Question: Author a descriptive caption for the visualization shown.
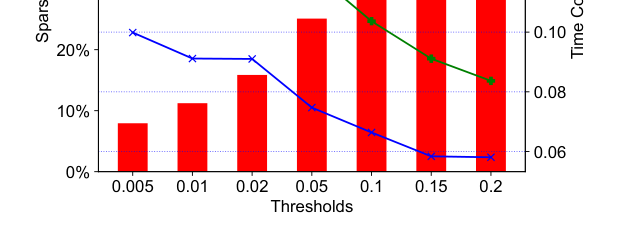
Answer: Variation of sparsity and the ability to keep sensitive information under different thresholds. Images are tested in the latent space. The red bars denotes to the percentage represented sparsity. The blue line and the green line are the cosine similarity between the remained image (encrypted part), the removed part and the original image, respectively.